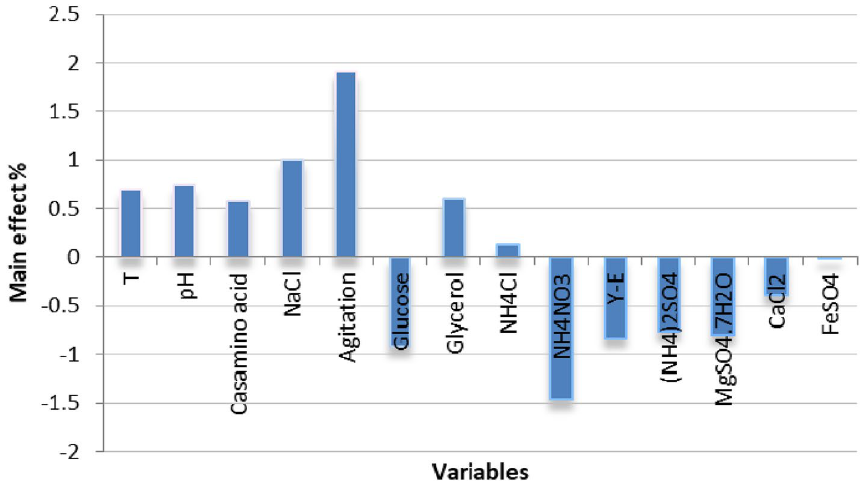
Figure 2. Main effect of the different factors influencing the biosurfactant production by Natrialba sp. M6 based on